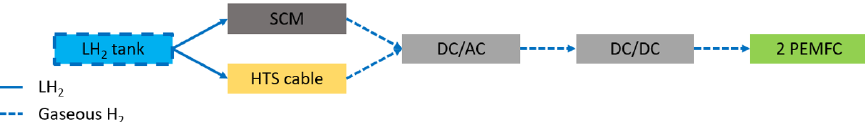
Figure 7. Hydrogen flow from the fuel tanks to the fuel-cell system; full line representing liquid hydrogen and dotted line representing gaseous